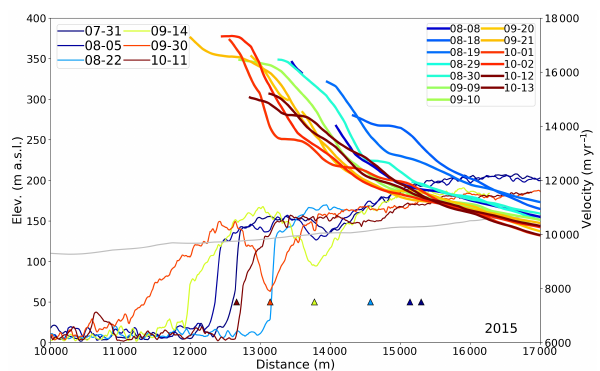
Figure 7. Elevation and velocity profiles for summer 2015 illustrat- ing the evolution of an advecting transverse surface depression. The legends give the nominal dates (MM-DD) in 2015. As in Fig. 3, the grey line indicates nominal height of flotation. The triangles show the estimated locations (see text) of the parcel of ice that evolved to form the bottom of the depression discussed in the text (white circles in Fig. 8), which served as a detachment point for a calving event (or events) that occurred between 30 September and 11 Octo-